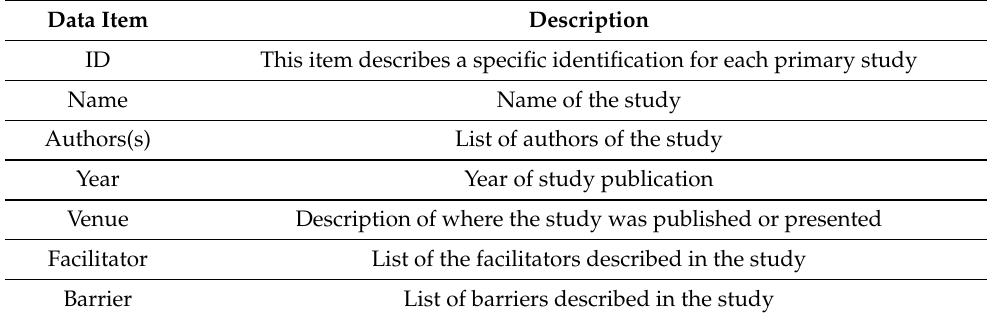
Table 2. Description of the template used to characterize primary